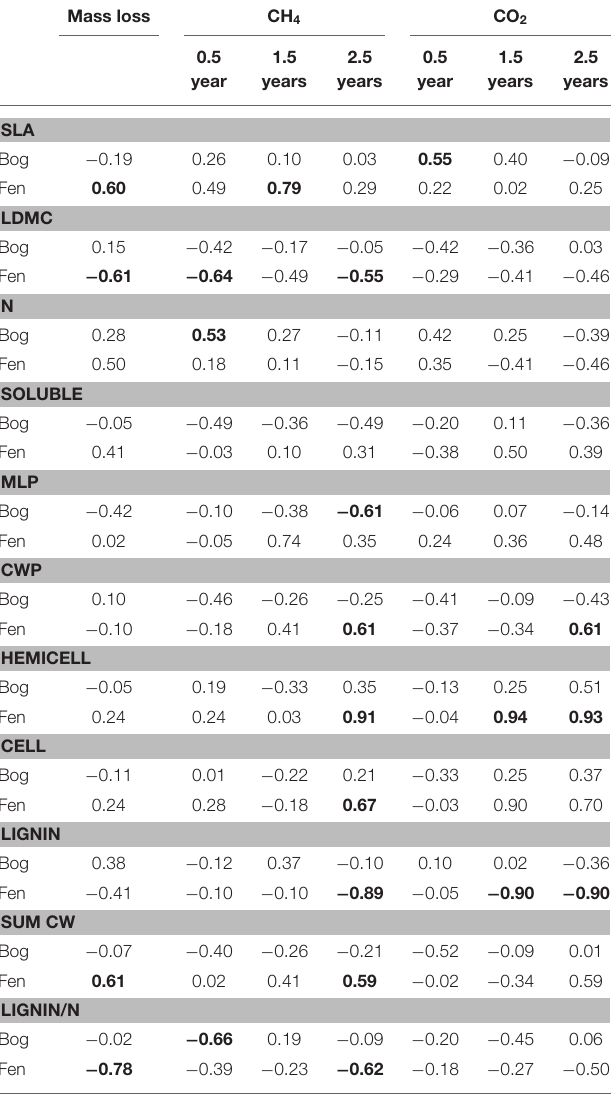
TABLE 6 | Pearson correlation between aspects of leaf litter quality and mass loss and rates of CH 4 production and CO 2 by decayed residue. Mass